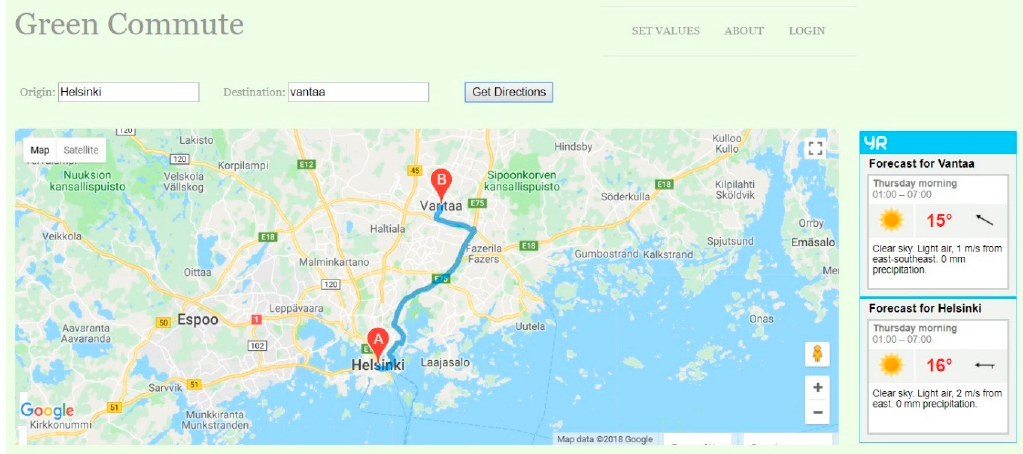
Figure 6. Sustainable smart city service in the form of the Green Commute application.